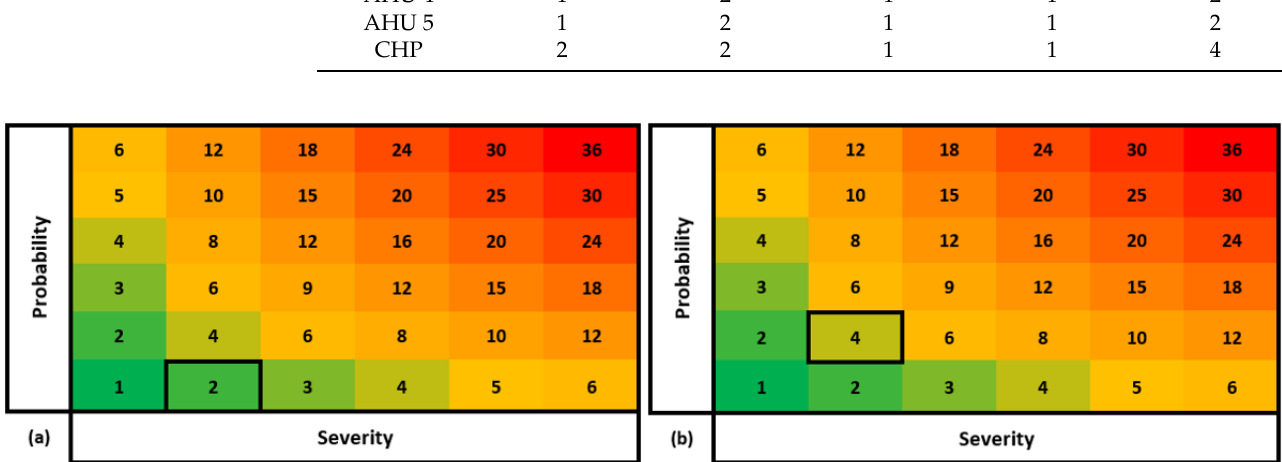
Figure 3. Severity vs. probability matrix demonstrating ( a ) a level 2 performance for an AHU Failure and ( b ) a level 4 performance for a CHP unit failure.